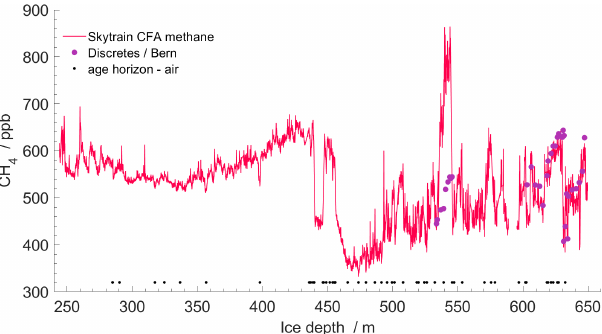
Figure 3. Continuous (CFA) methane (red line), and data from discrete measurements (purple dots), after removal of occasional methane spikes as discussed in the text. The discrete data confirm that the continuous data between 534 and 545m are offset and con- firm that the uncalibrated values for the remaining continuous data are reasonable. Tie points used to construct the age scale are shown as black